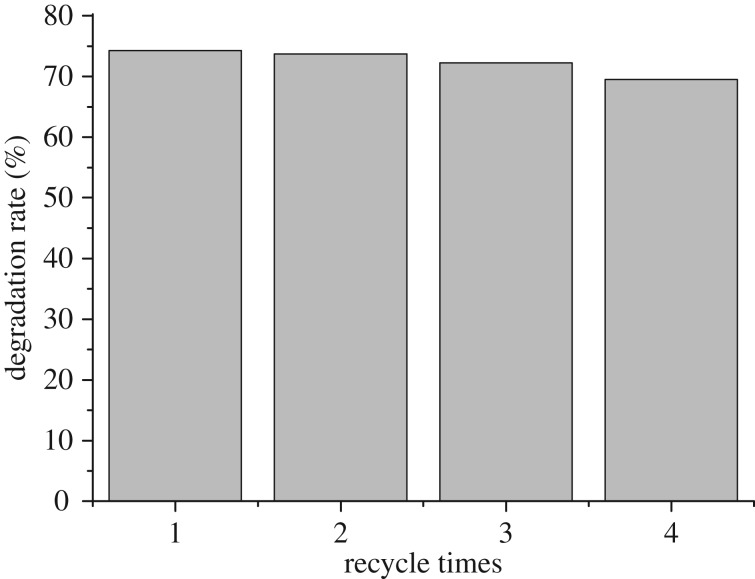
Reusability of Fe3O4.